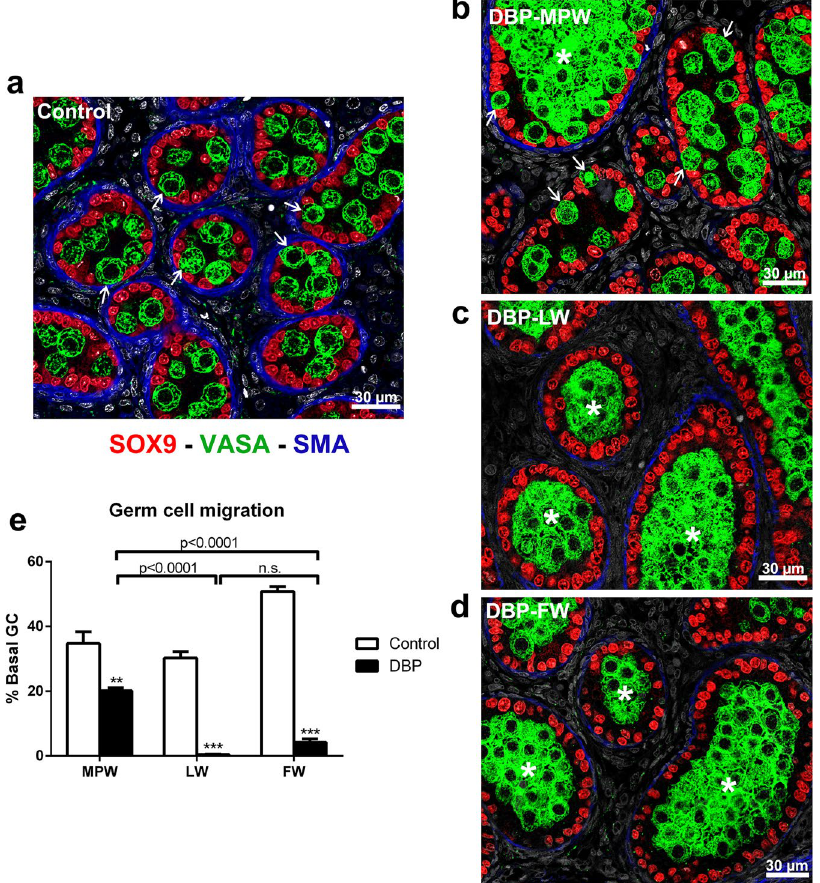
Figure 7. Quantitative analysis of the effect of DBP exposure on germ cell migration to the basal lamina in the e21.5 rat testis. Sections were triple immunostained for SOX9 (red, Sertoli cells), VASA (green, germ cells), and smooth muscle actin (blue, peritubular myoid cells and some blood vessels). In ( a ), note that in controls at this age the germ cells are migrating outwards to the basal lamina of the cords (arrows). In ( b–d ), after DBP exposure germ cells are clustered in the centre of the cords (asterisks), but this is less extensive in the DBP- MPW group ( b ) in which some germ cells still show migration to the basal lamina (arrows), whereas this is rarely seen in the DBP-LW ( c ) and DBP-FW ( d ) groups. ( e ) Quantitative analysis of the percentage of basally migrated germ cells (GC) in the different treatment groups. Values are means ± SEM for 5–6 animals per group. Data were analyzed by Student’s t-test, when comparison involved only two groups (control vs. DBP-exposed); and by one-way ANOVA followed by Tukey’s post-hoc test, when appropriate. ** p < 0.01, *** p < 0.001, n.s. = not